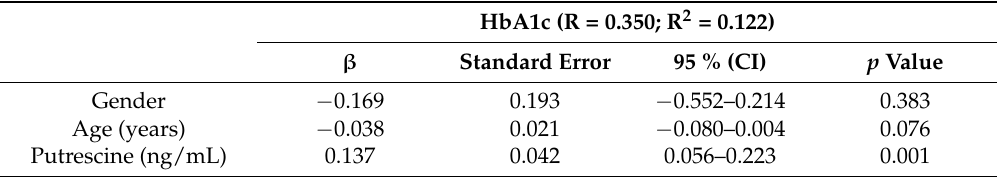
Figure 2. Spearman correlations of serum arginine or polyamine (putrescine and spermine) levels with clinical parameters related to T2D. Table 3. Linear regression analysis with HbA1c as the dependent variable, and gender, age and putrescine as independent parameters.